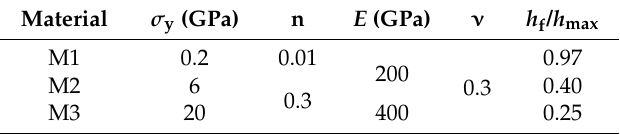
Table 3. Mechanical Properties of The Materials Used in the Study of The Knoop Indentation